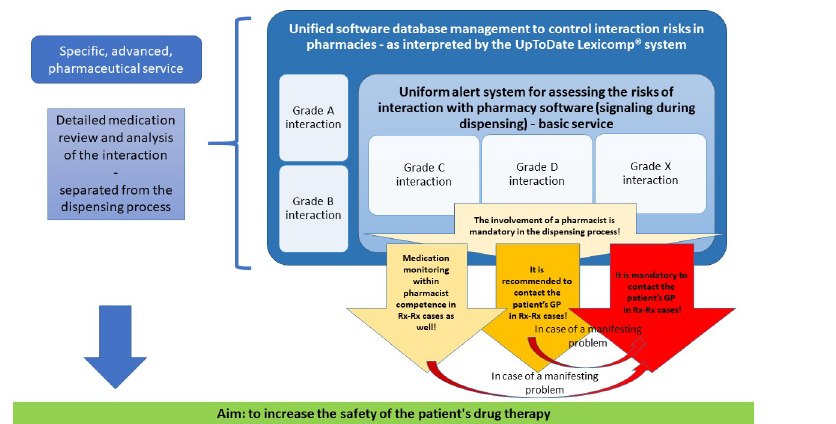
Fig 7. Proposal for a uniform pharmacy procedure for the management of interaction